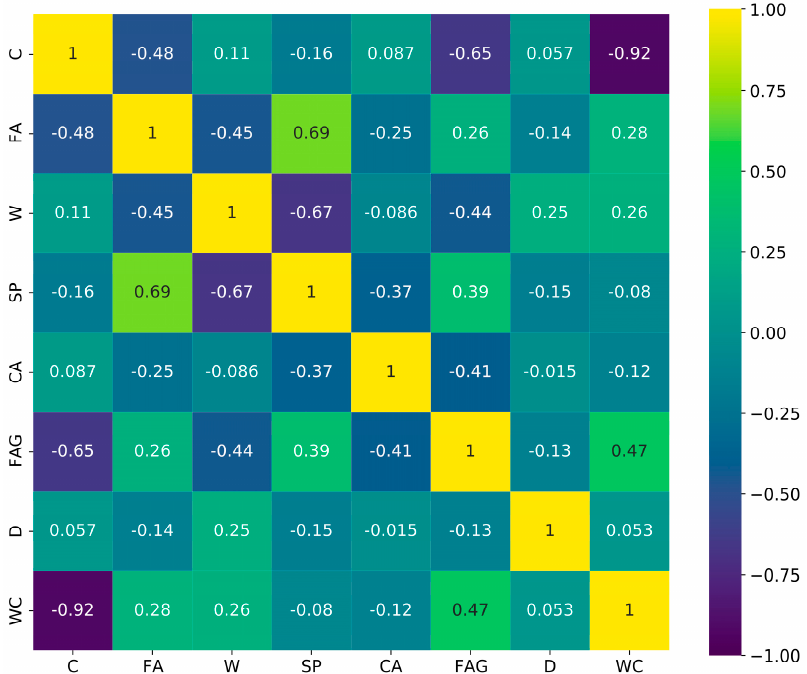
Figure 1. Correlation matrix.